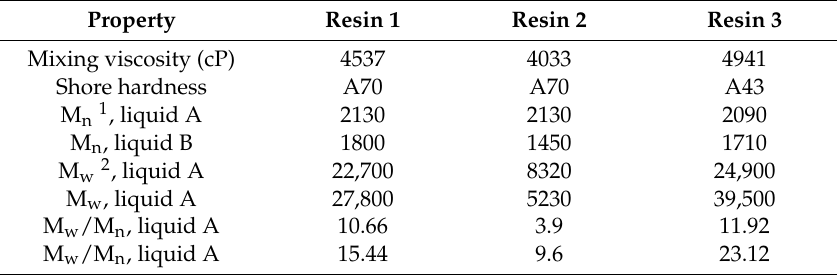
Figure 1. Overview of the phosphor film fabrication process ( a ) design and fabrication of elastic mold; ( b ) phosphor slurry dosing; ( c ) thermal curing; ( d ) phosphor film transferred to dicing tape; ( e ) fabricated phosphor film. Table 1. Three types of methyl silicone